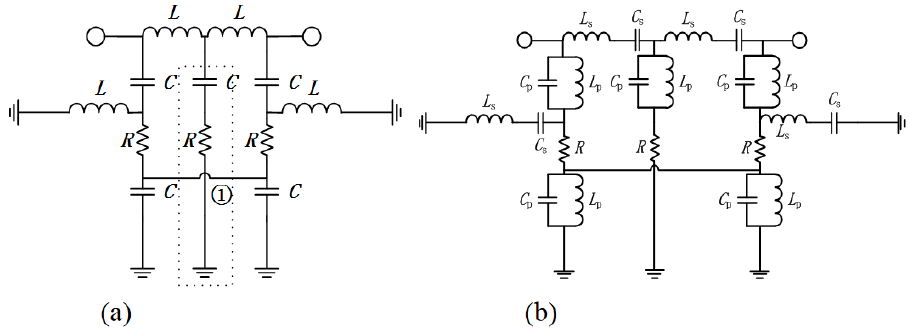
Figure 1. The circuit topologies of ( a ) the reflectionless low-pass filter and ( b ) the proposed reflectionless band-pass filter.